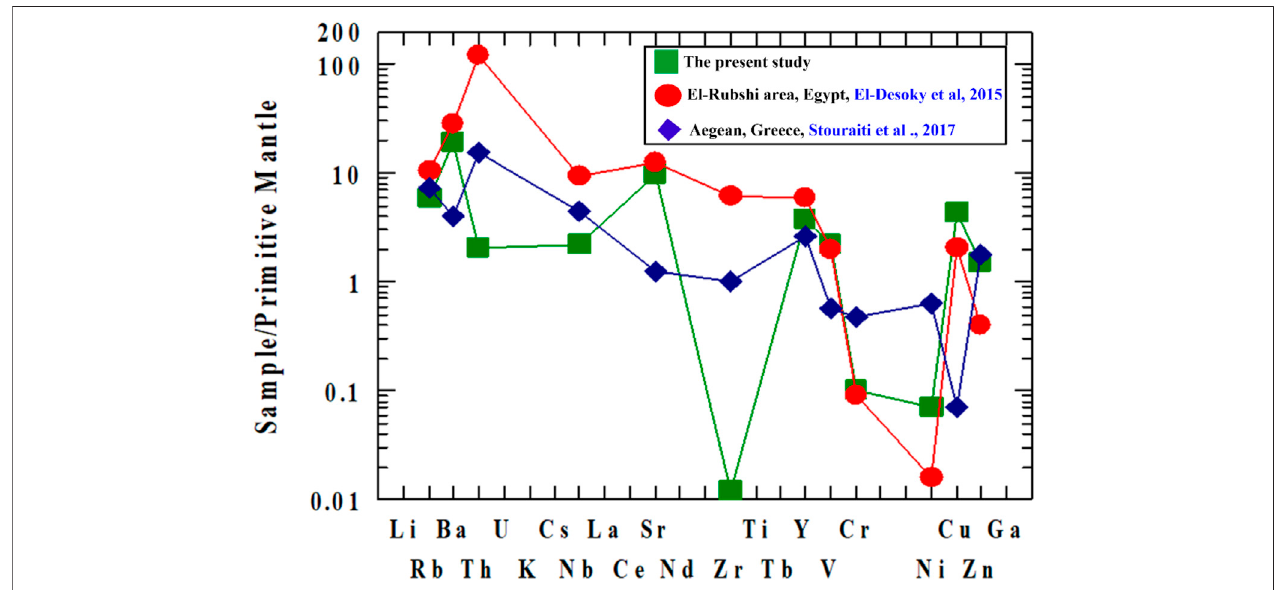
FIGURE12| PM-normalizationvaluesofaveragegeochemicalresultsofpresentamphibolitesamplescomparedwithEl-Rubshi(Egypt)andAegean(Greece)area.